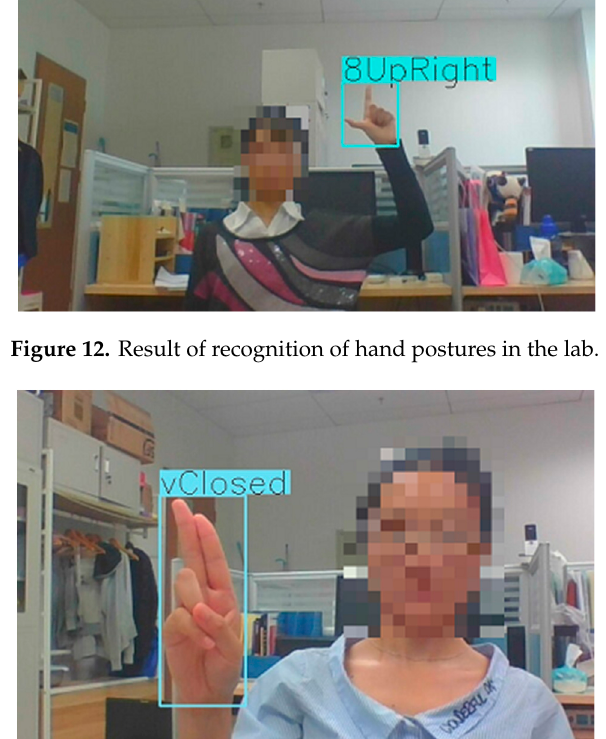
Figure 13. Result of recognition of hand postures in the lab.